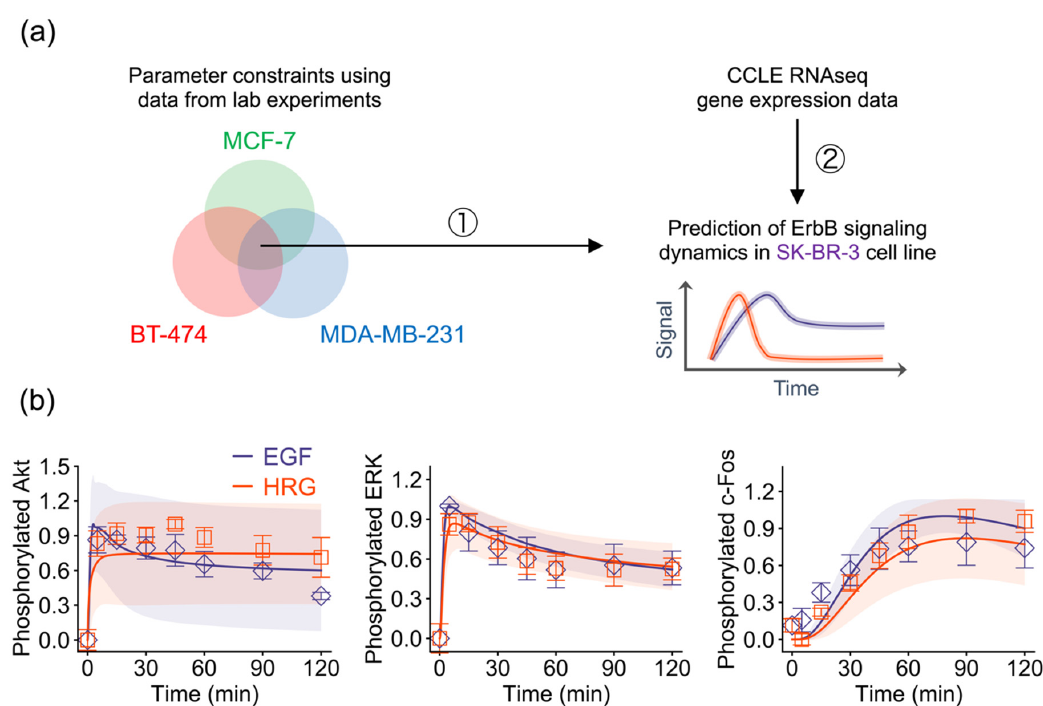
Figure 4. Prediction of ErbB signaling dynamics in the SK-BR-3 cell line. ( a ) Strategy for model-based prediction. ( b ) Predicted signaling dynamics and experimental observations. Points: Experimental data (blue, EGF; red, HRG); solid lines: Averaged in silico simulation results of the 30 parameters; shaded areas: Simulation standard deviation.